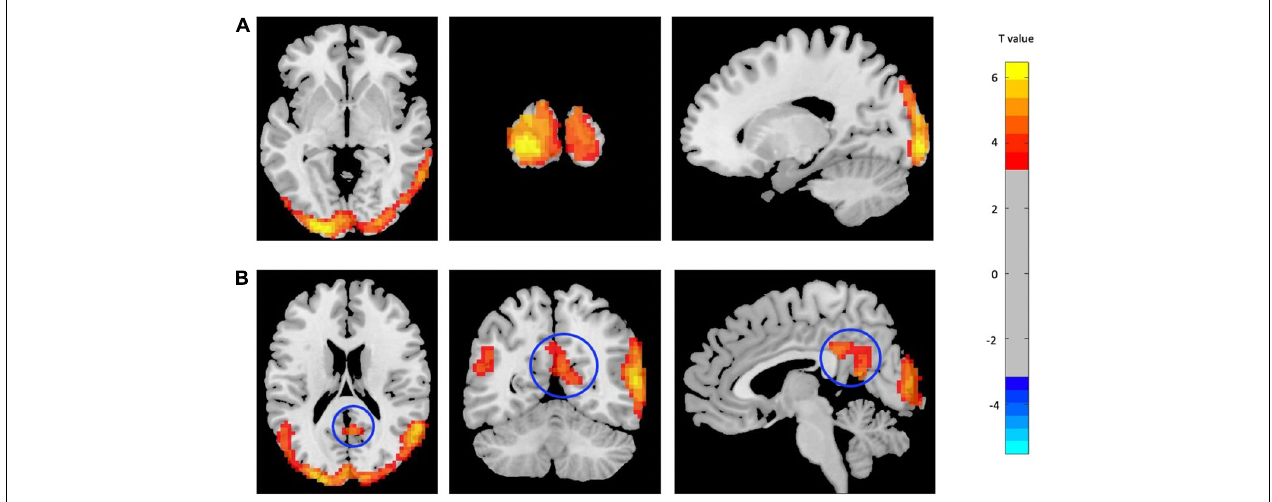
FIGURE 2 | Increased ReHo in mTBI patients compared with controls in the clusters including (A) Occipital_Mid_L, and (B) Cingulate_Post_L ( p -value < 0.001, FDR-corrected). The range of t -values is represented by the color bar. Hot colors corresponding with increased ReHo values in the mTBI group. *Note that the right side of the image as displayed is the right side of the